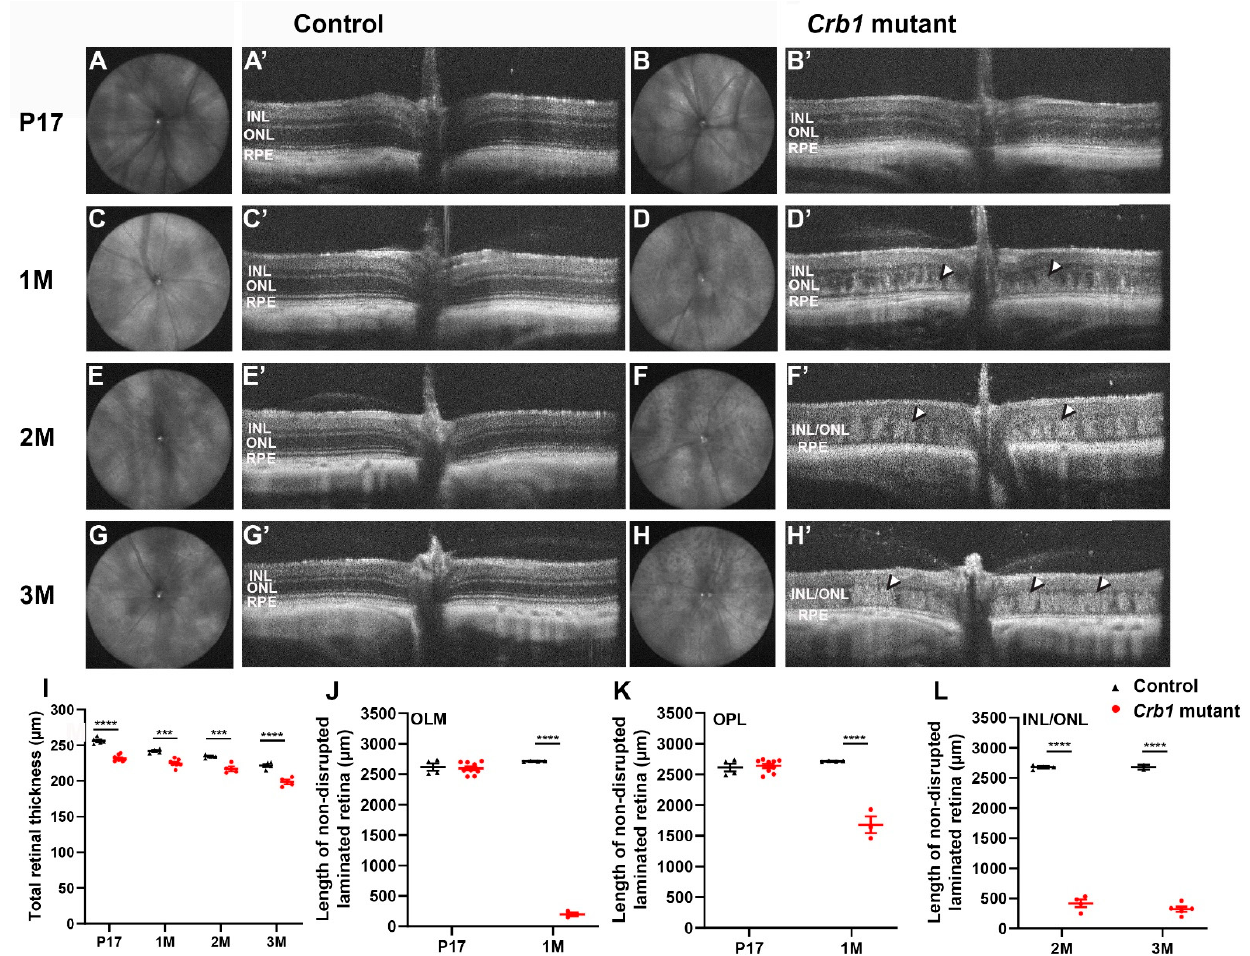
Figure 3. In vivo imaging of Crb1 mutant rats show increased retinal degeneration over time. Volume intensity projection (VIP) of the P17 and 1, 2 and 3 months of age control ( A , C , E , G ) and Crb1 mutant ( B , D , F , H ) rat retinas; and SD-OCT B-scans of the P17 and 1, 2 and 3 months of age control ( A’ , C’ , E’ , G’ ) and Crb1 mutant rat retinas ( B’ , D’ , F’ , H’ ). Quantifications of total retinal thickness ( I ), length of non-disrupted laminated retina at the OLM in P17 and 1-month-old control and Crb1 mutant rats ( J ), at the OPL ( K ), and in 2 and 3 months of age rats at the INL/ONL ( L ). Arrowheads indicate regions of retinal disorganization. Number of animals used for P17 (control n = 6, Crb1 mutant = 9), 1M (control n = 4, Crb1 mutant n = 9), 2M (control n = 4, Crb1 mutant n = 4) and 3M (control n = 2, Crb1 mutant n = 5). Values are presented as the mean ± SEM. *** p < 0.001, **** p < 0.0001. INL = inner nuclear layer; ONL = outer nuclear layer; OPL = outer plexiform layer; RPE = retinal pigment epithelium.